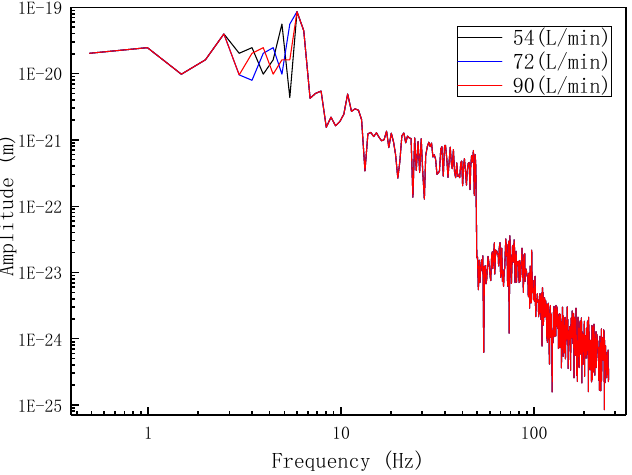
Figure 9. Vibration frequency variation of the inner leaching tubing with different water injection rates for direct circulation.